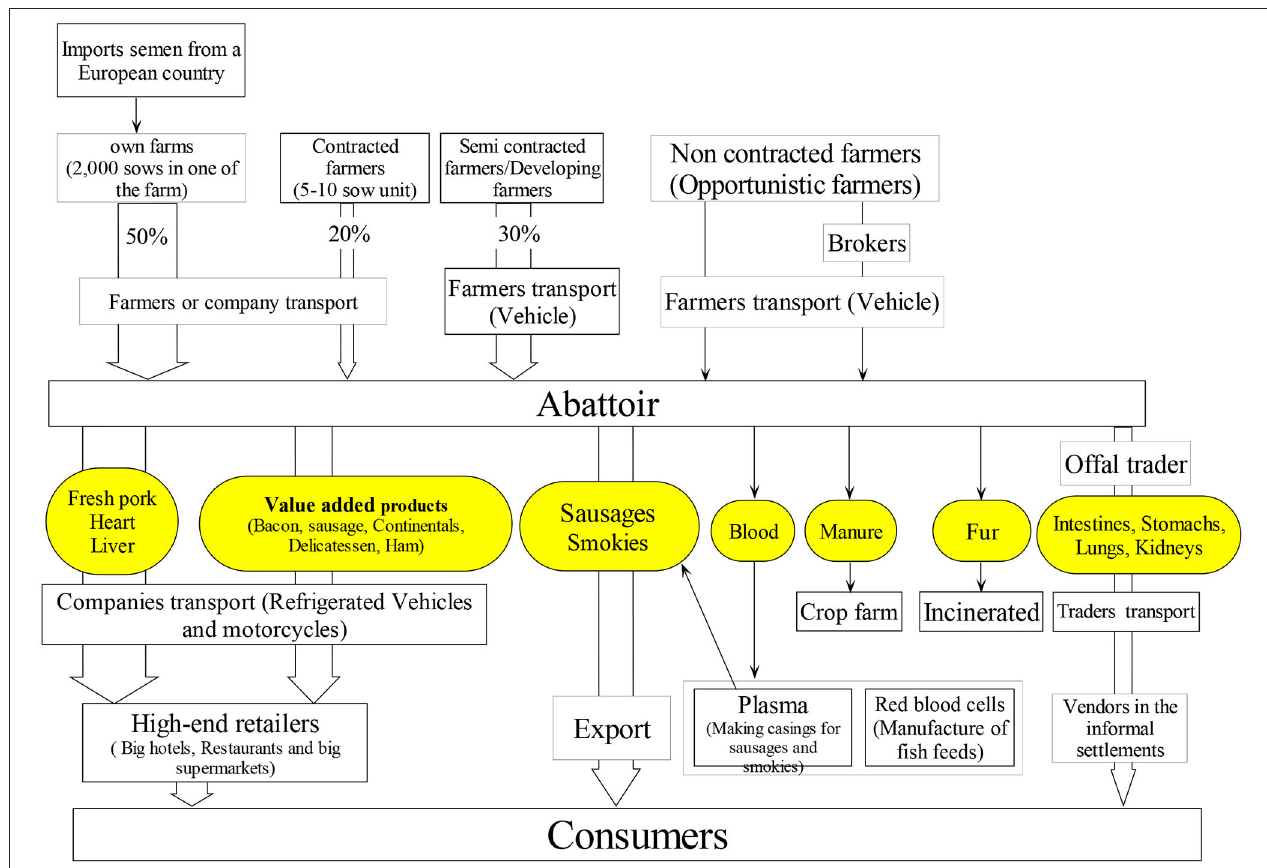
FIGURE 4 | Integrated Company (IC) profile: The flowchart shows sources and flows of pig and pork meat in a nearly fully integrated production system. The IC has owned farms that produce 50% of their throughput with the rest being supplied by contracted and semi contracted farmers. Notes: Oval shapes colored yellow indicates commodities traded; arrows indicate the flows of products. The arrow width indicates proportional importance in terms of